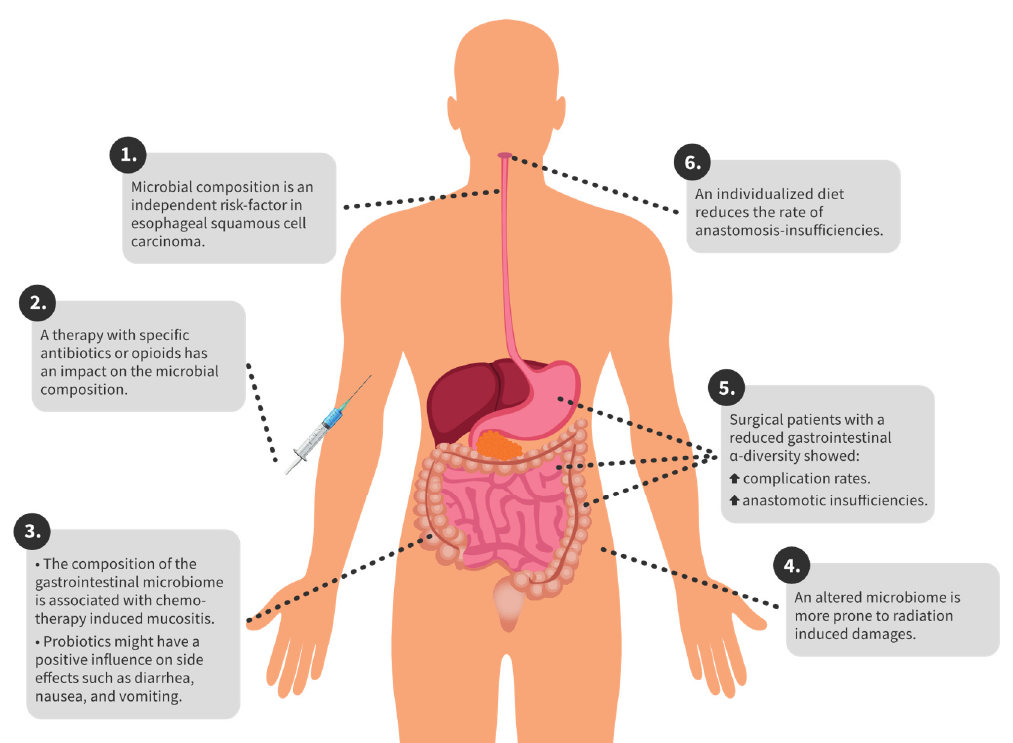
Figure 1. Overview of key findings.